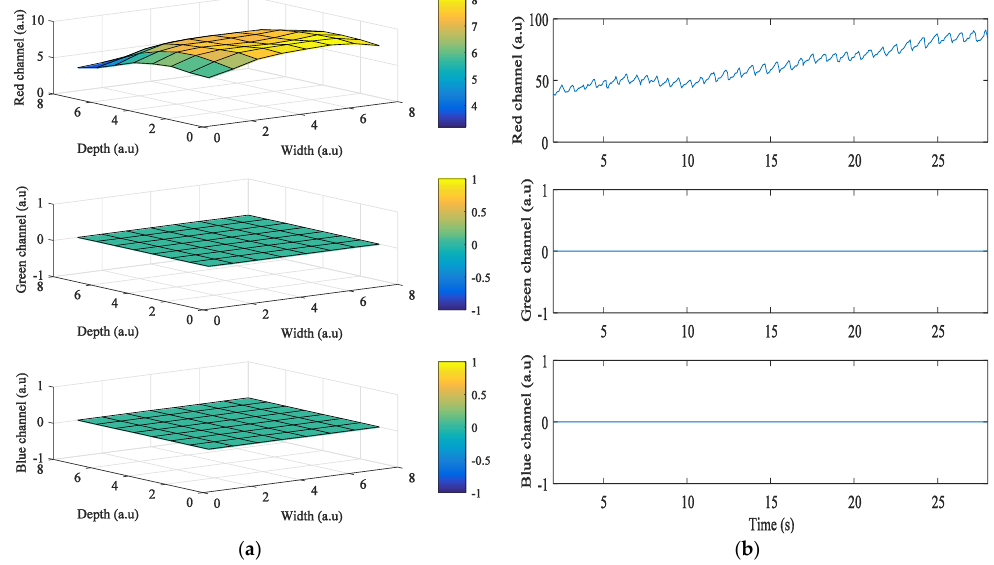
Figure 14. Example of quality analysis of PPG signals obtained from a subject using the Galaxy Note 3 with flash off: ( a ) intensity change distribution; ( b ) intensity of PPG signal.